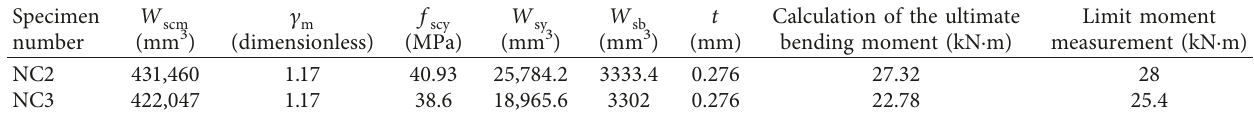
Table 5: Parameters related to the limit bending moment.